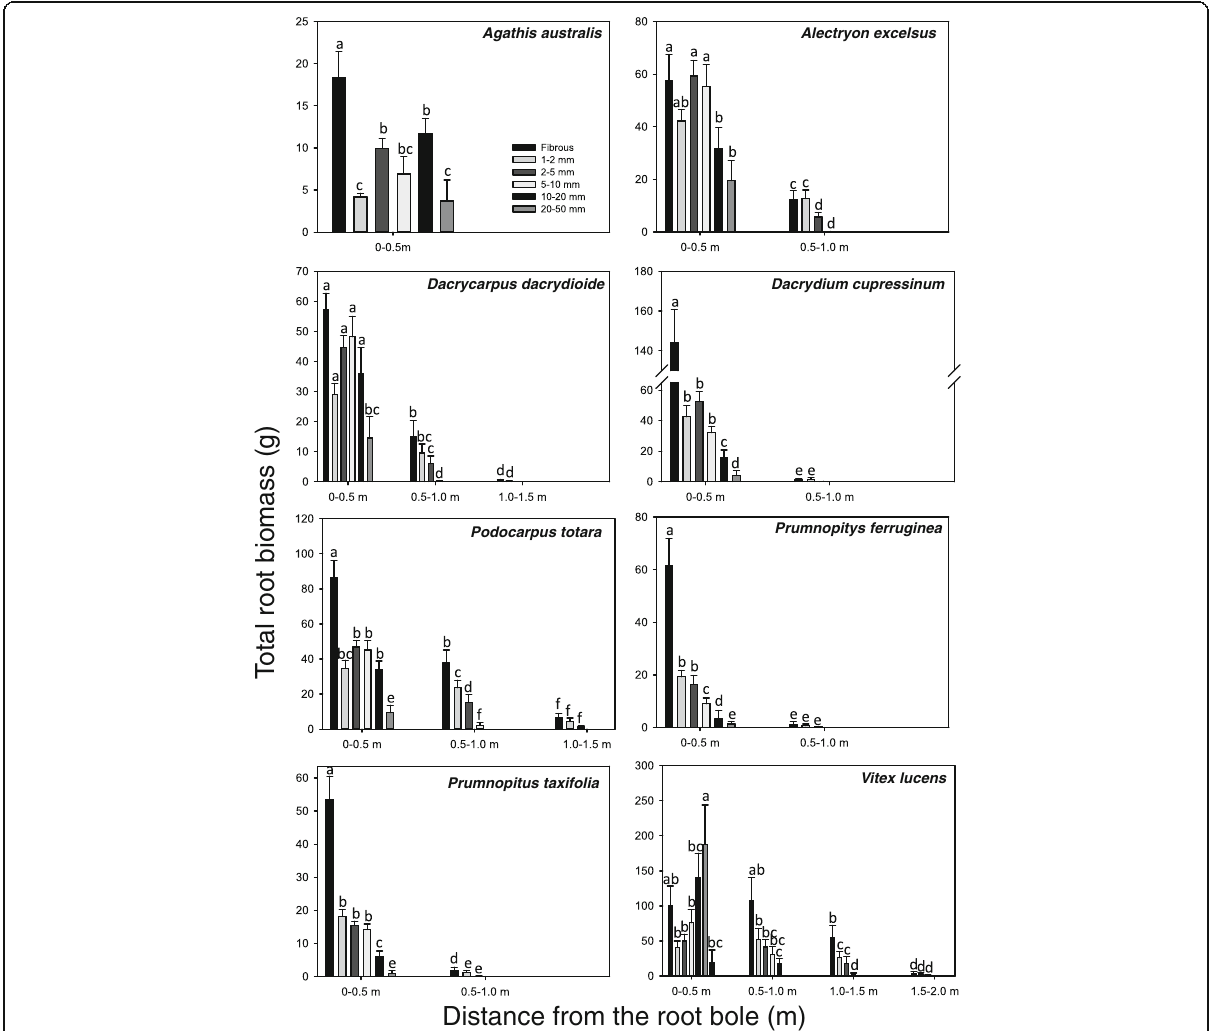
Fig. 7 Distribution of total root biomass with increasing radial increments from the root bole. Note that the scale on the y axis differs between